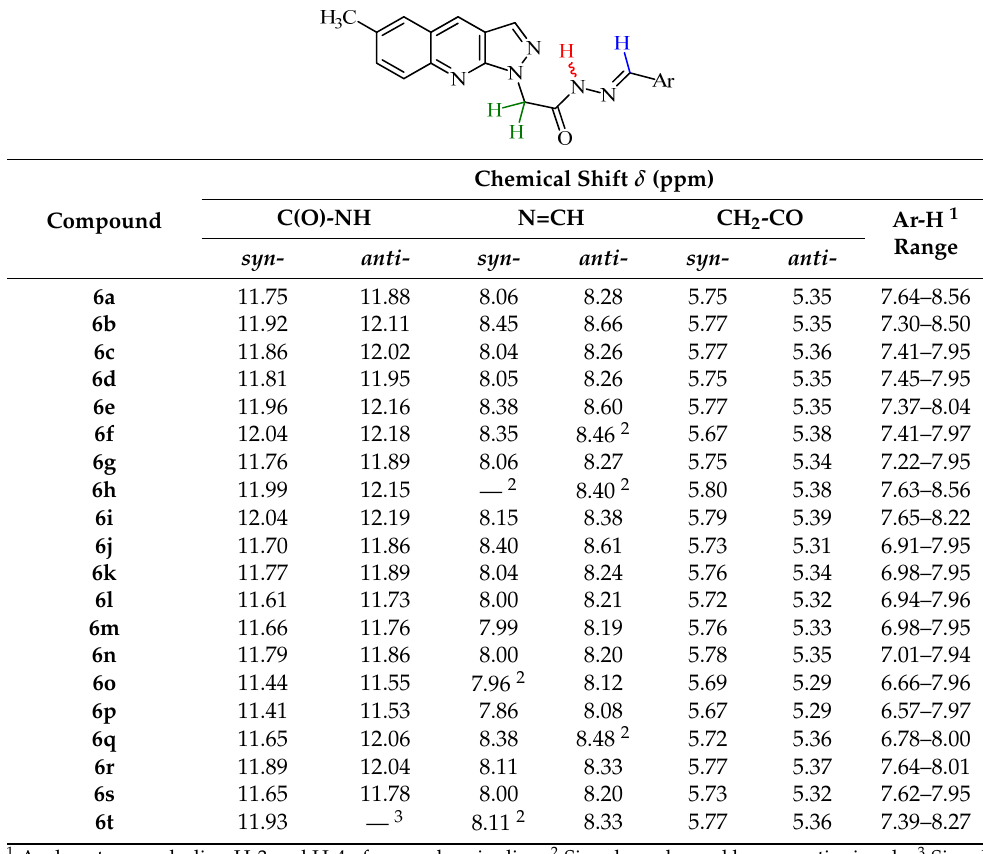
Table 1. Chemical shifts of duplicated peaks in 1 H NMR spectra of compounds 6 ( a–t ) in DMSO- d 6 .